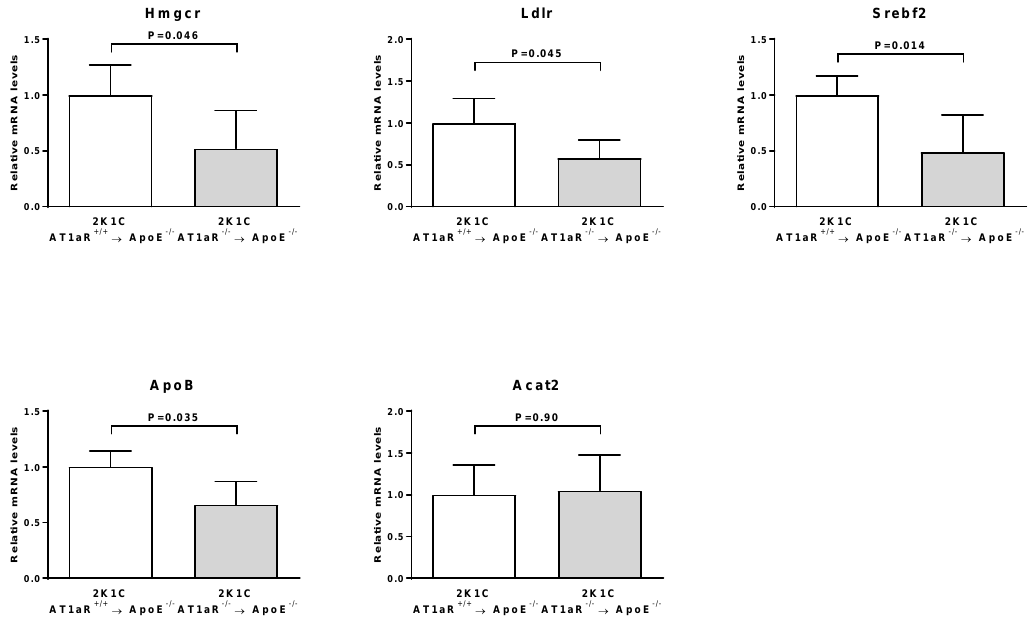
Figure 1. Effect of AT1aR deficiency in BM-derived cells on genes involved in cholesterol metabolism. mRNA levels of Hmgcr, Ldlr, Srebf2, ApoB, and Acat2 were determined in liver tissue by real-time RT-PCR analysis. Data were normalized to 36B4 and expressed as fold change over controls which were set at 1. n = 9 animals per group.